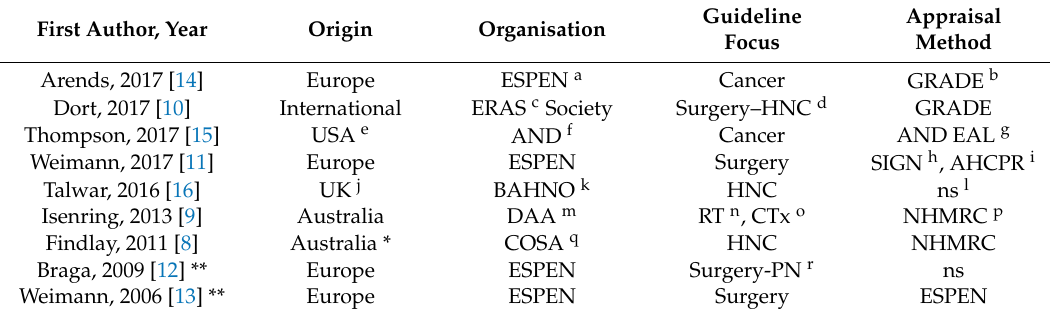
Table 1. Evidence-based clinical practice guidelines for nutritional management of adults with cancer.